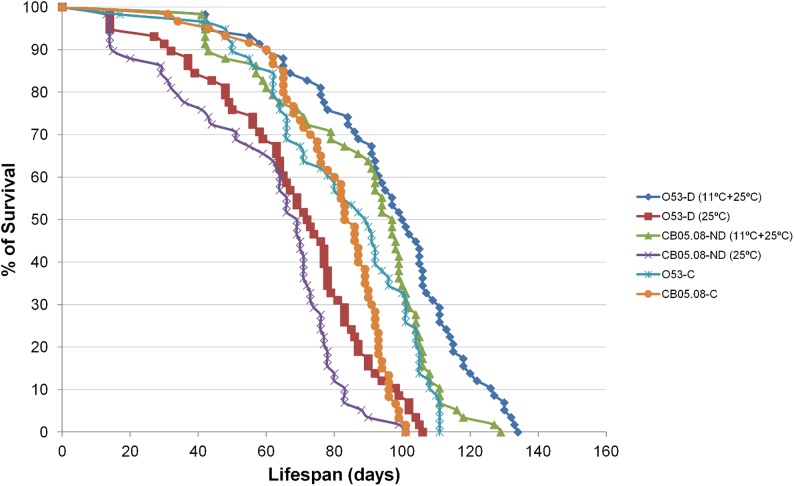
Diapause inducing conditions increase LS, which is more pronounced in diapausing females when compared with non-diapausing ones.Survival curves throughout time are shown for D. americana strains O53 (diapausing) and CB05.08 (non-diapausing) reared under non-diapause inducing conditions (12L:12D at 25°C; controls) and at the same conditions after being reared for 28 days under diapause inducing conditions (10L:14D at 11°C; O53-D (11°C+25°C) and CB05.08-ND (11°C+25°C)). Additional curves are presented for the same O53-D and CB05.08-ND females, but with LS measured starting from the day they were transferred into non-diapause inducing conditions (25°C).